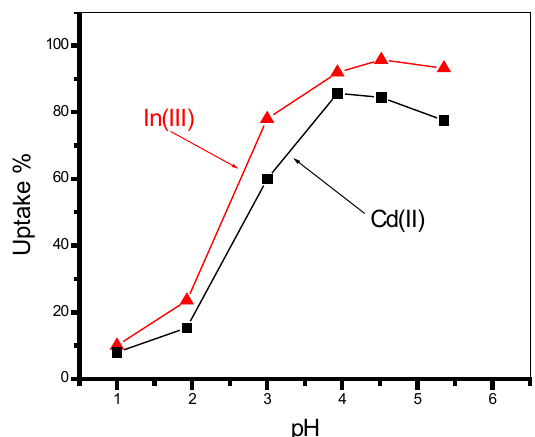
Figure 1. The effect of pH on the adsorption of In(III) and Cd(II) by Dowex 50w-x8.